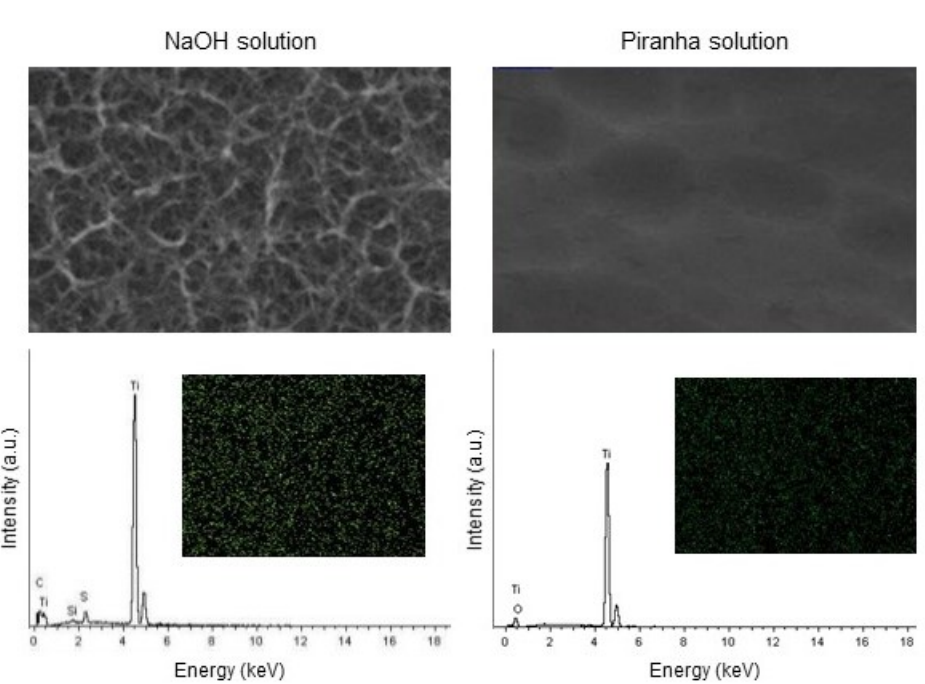
Figure 2. SEM micrographs and EDS-SEM of fully dense Ti substrates, after etching with NaOH or piranha reagents.